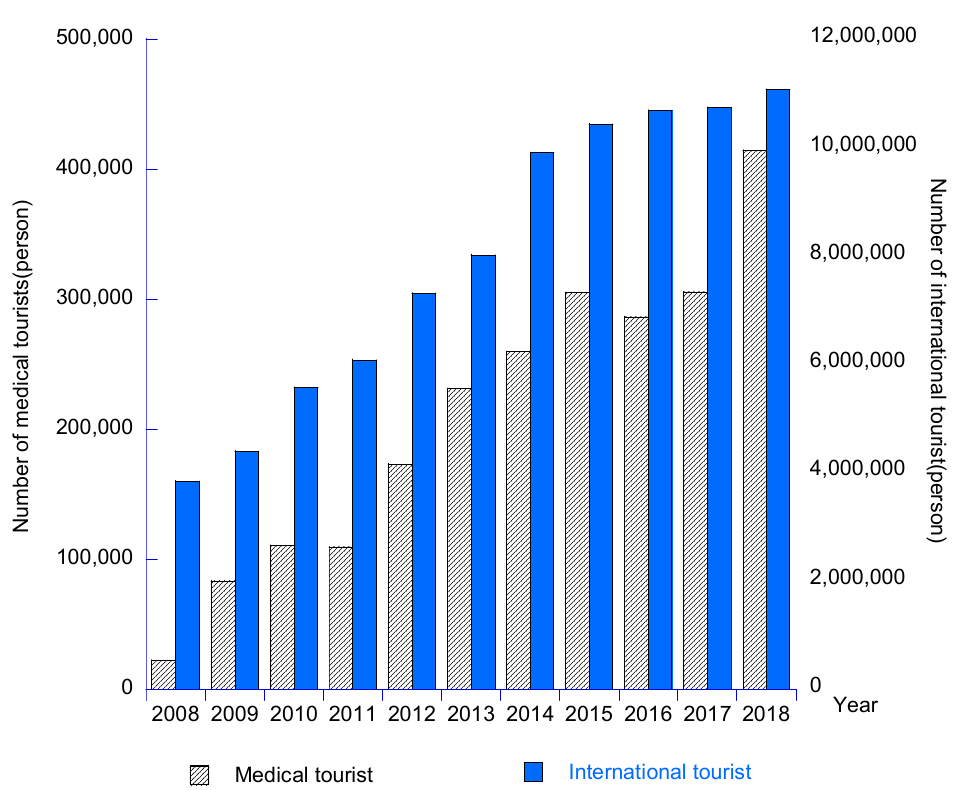
Figure 3. Status of medical tourist and international tourist in Taiwan over the past ten years.